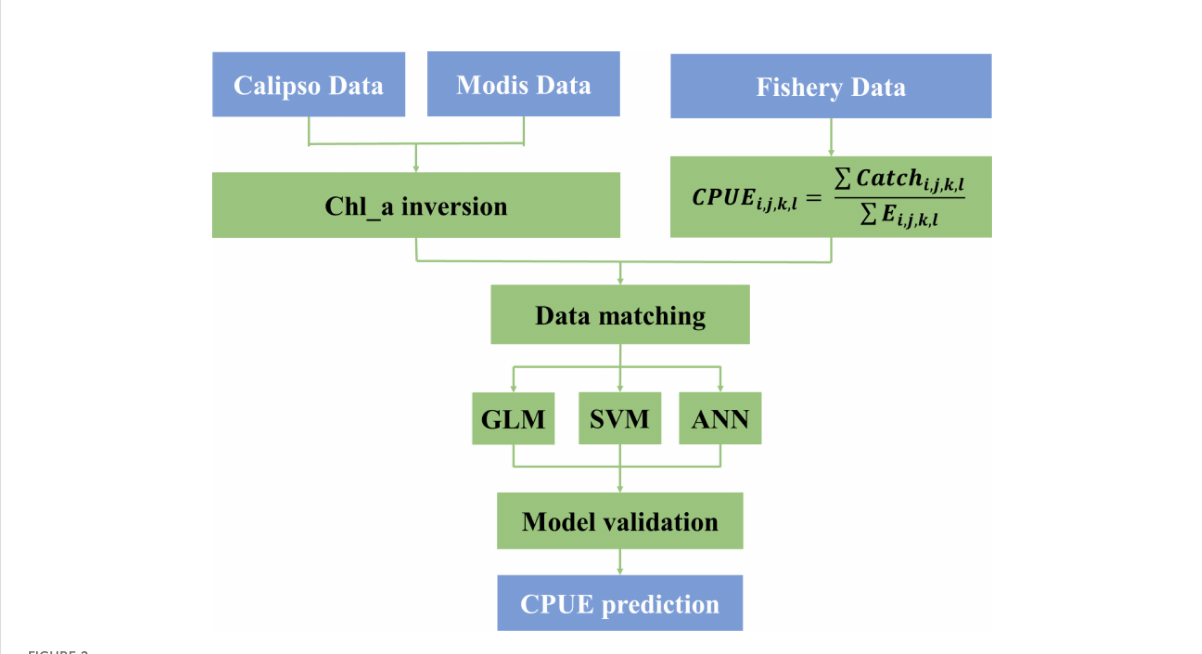
FIGURE 2 Flow chart of this